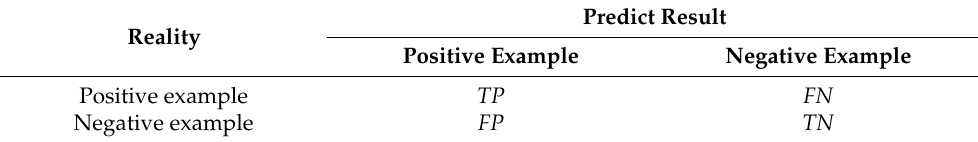
Table 4. Meaning of TP , FP , TN , FN